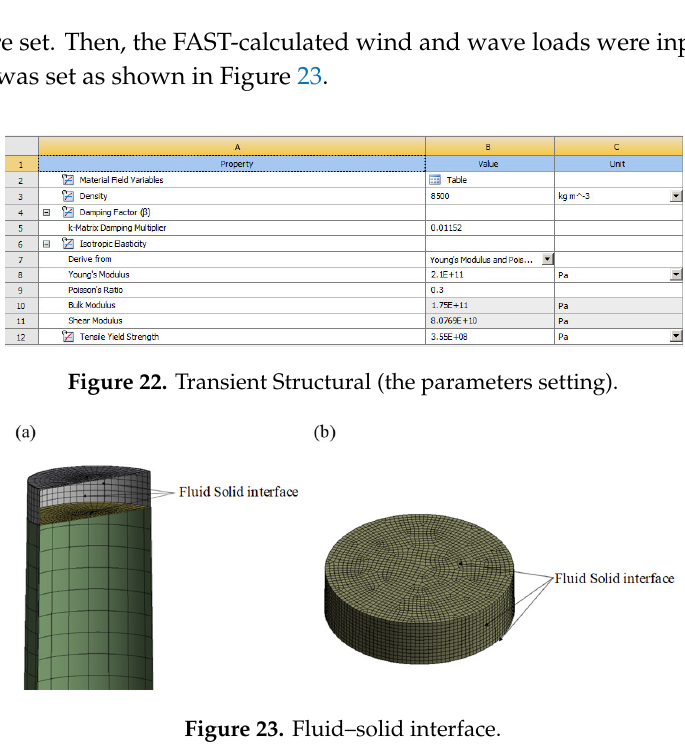
Table 4. The convergence test for tower FEM mesh selection.